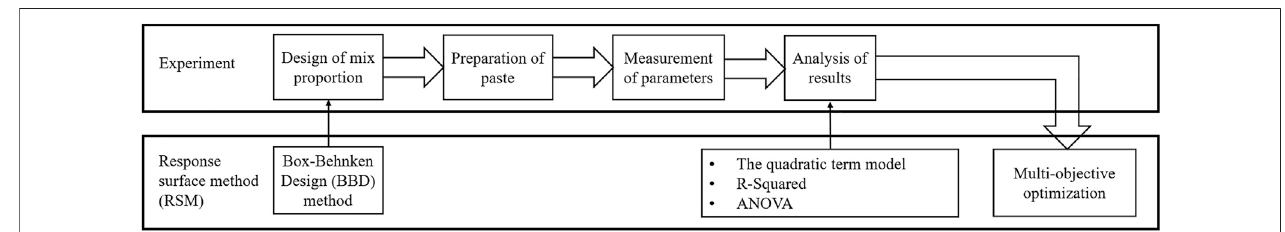
FIGURE 7 | The fl ow chart of the